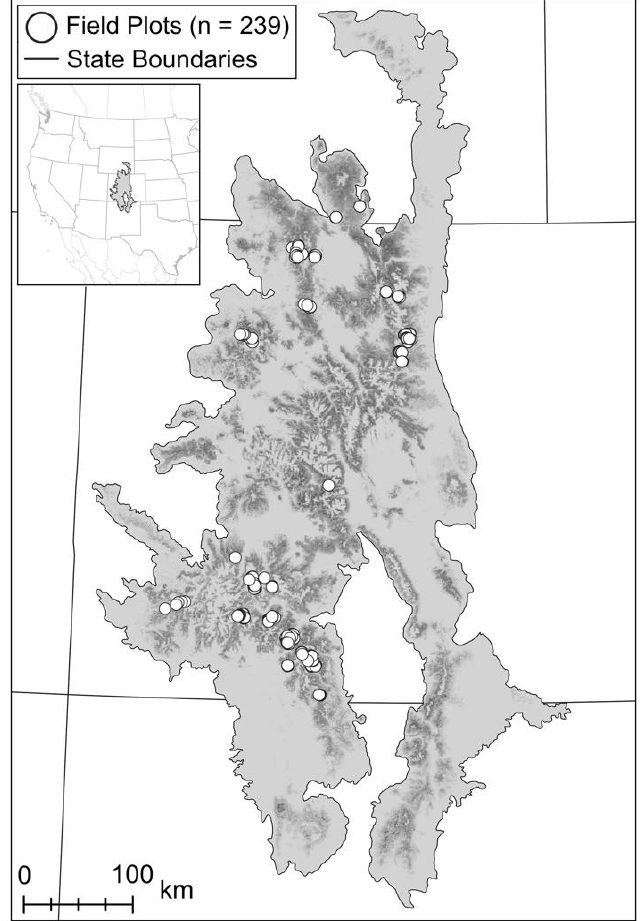
Figure 1. Study area and the locations of 239 field plots used to inform remotely sensed estimates of cumulative tree mortality due to bark beetle attack (1997–2019) in the Southern Rocky Mountains, USA. We focused specifically on subalpine forests dominated by Engelmann spruce, limber pine, lodgepole pine, and/or subalpine fir. Background shading (light grey [absent] to black [prevalent]) illustrates the abundance of these subalpine tree species [42].